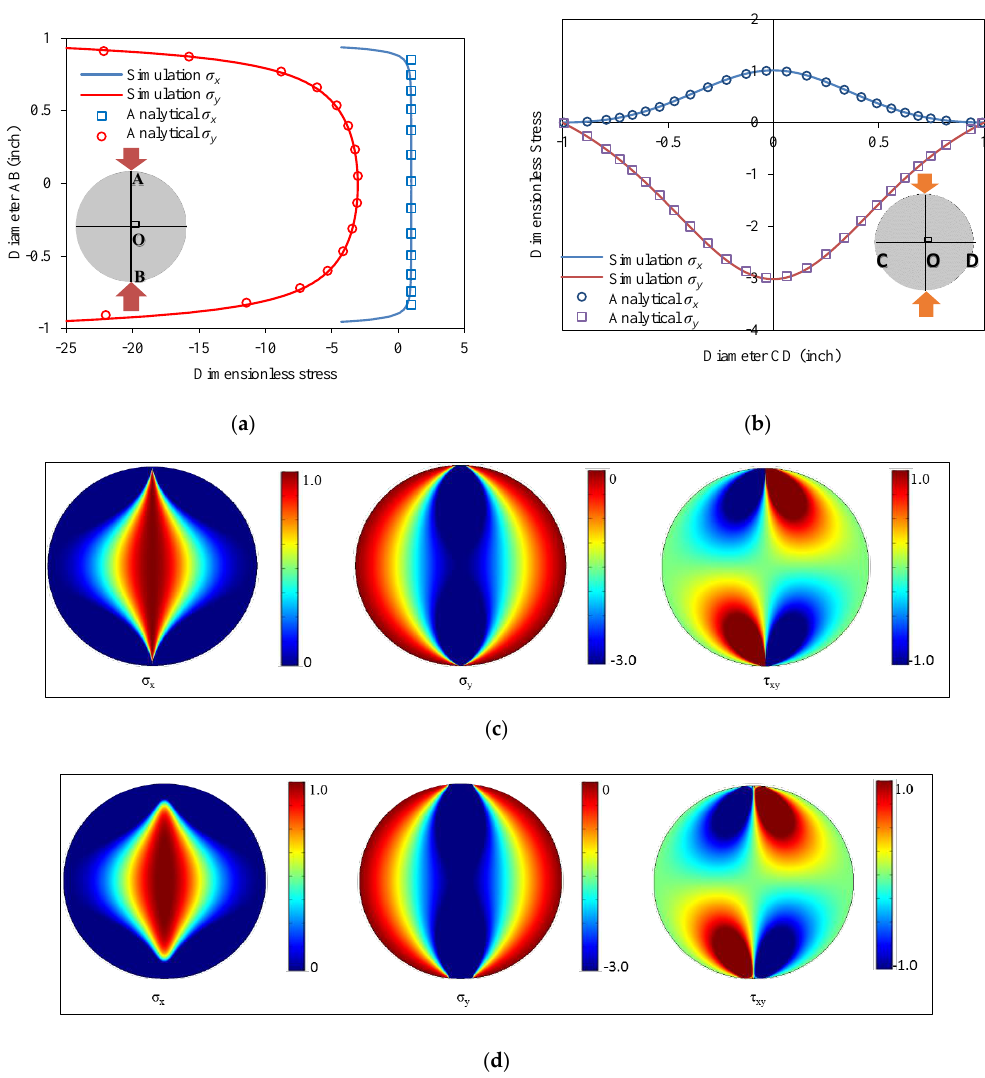
Figure 6. Verification of analytical results with numerical solutions. ( a ) Dimensionless stress on the vertical diameter; ( b ) Dimensionless stress on the horizontal; ( c ) Dimensionless stress distribution from analytical solutions; ( d ) Dimensionless stress distribution from numerical solutions.